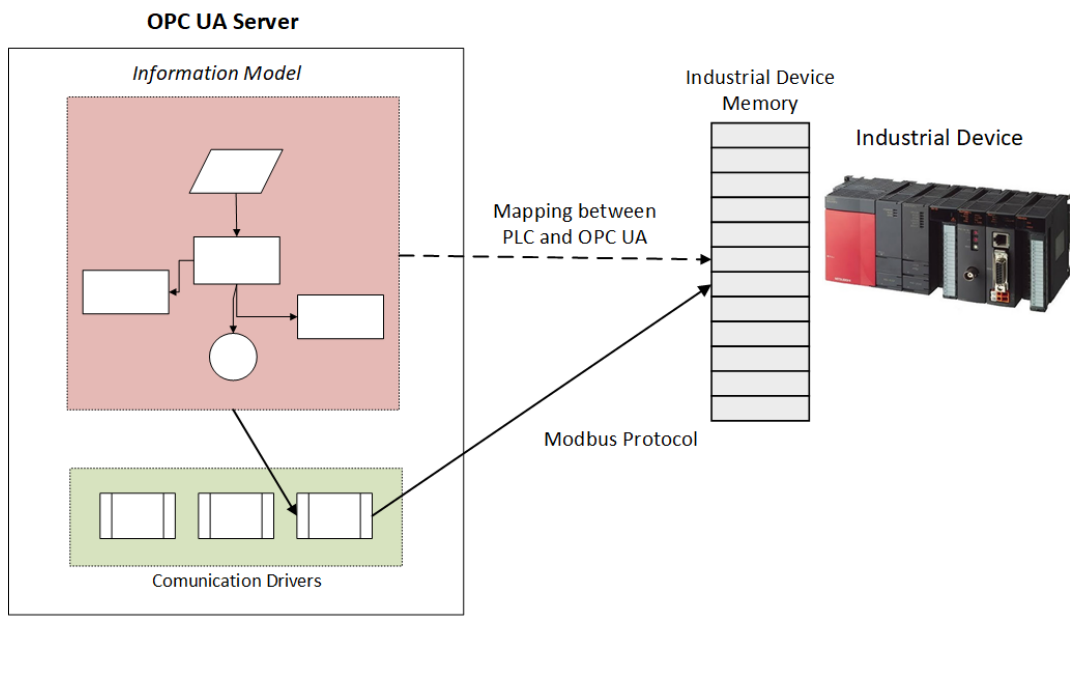
Figure 4. Schematic of the information exchange between the PLC device and OPC UA server once the auto-configuration of OPC UA is